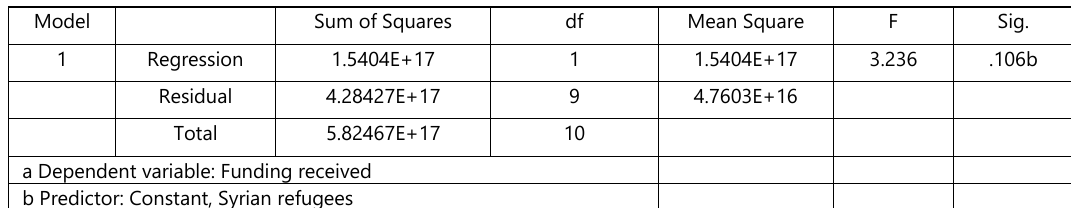
Table 4: ANOVA Analysis (Source: Author‘s research 2022)